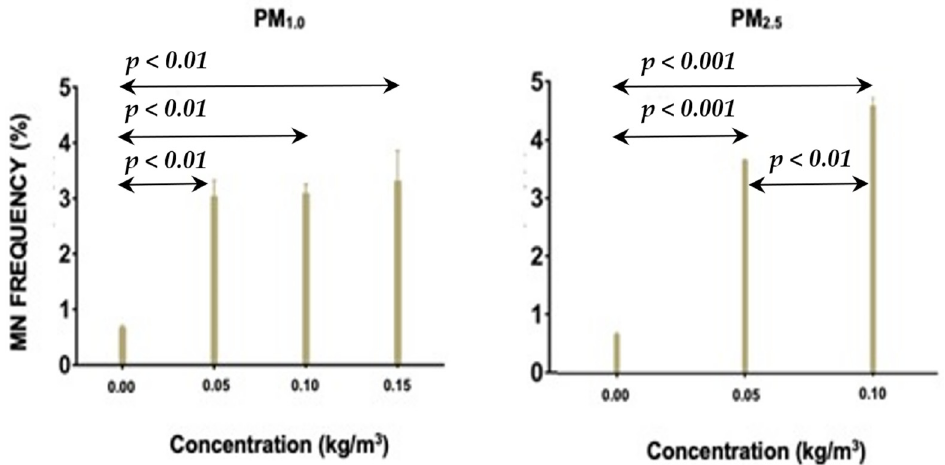
Figure 1. MN frequency of the two PM size fractions. Only the p -values which yielded a significant difference are shown.